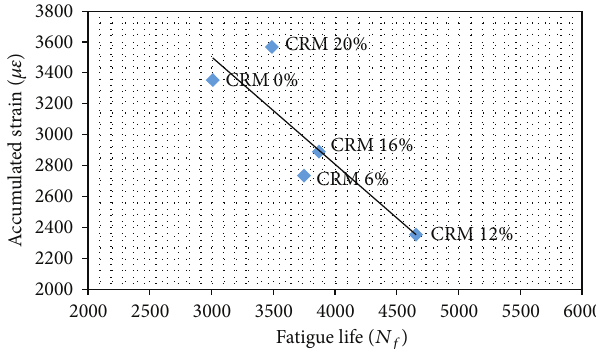
Figure 5: Fatigue life versus strain at 2500 N stress.